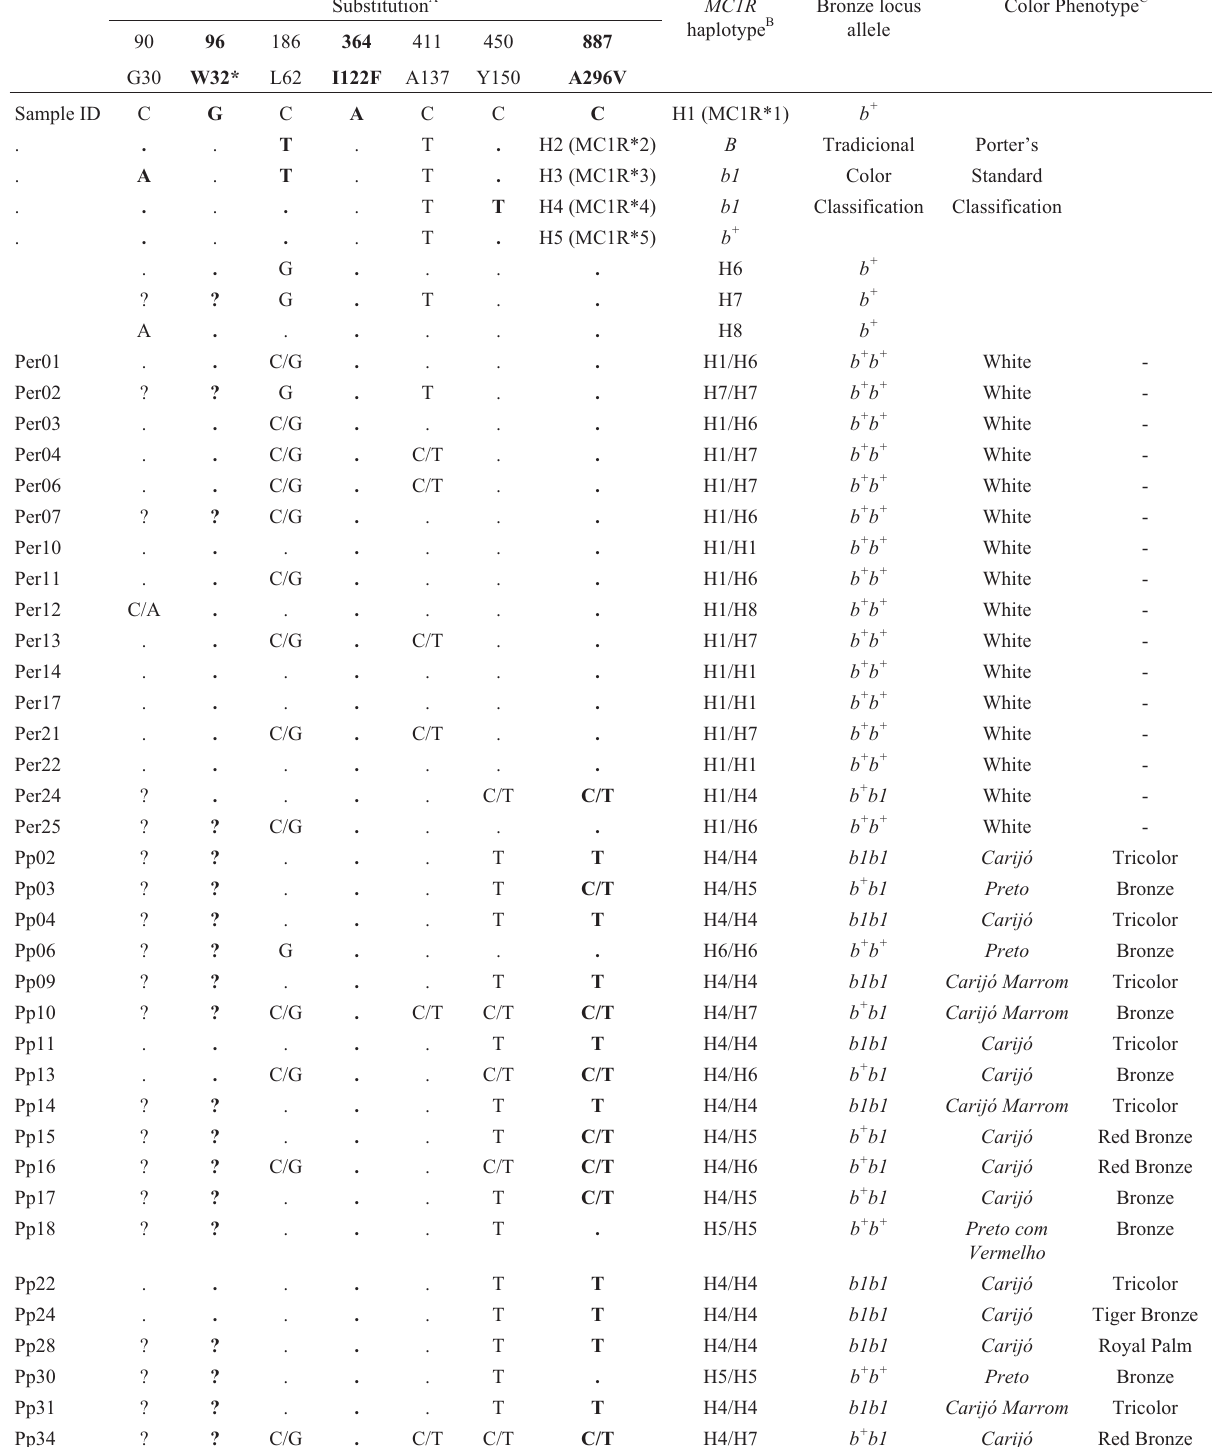
Table 1 - Molecular characterization of the turkey melanocortin-1 receptor gene ( MC1R ) and phenotype classification using the breeders’ traditional color classification and Porter’s Rare Heritage standard